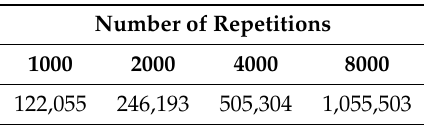
Table 10. Clock cycles of f 4 ( ¯x ) after being slowed down.